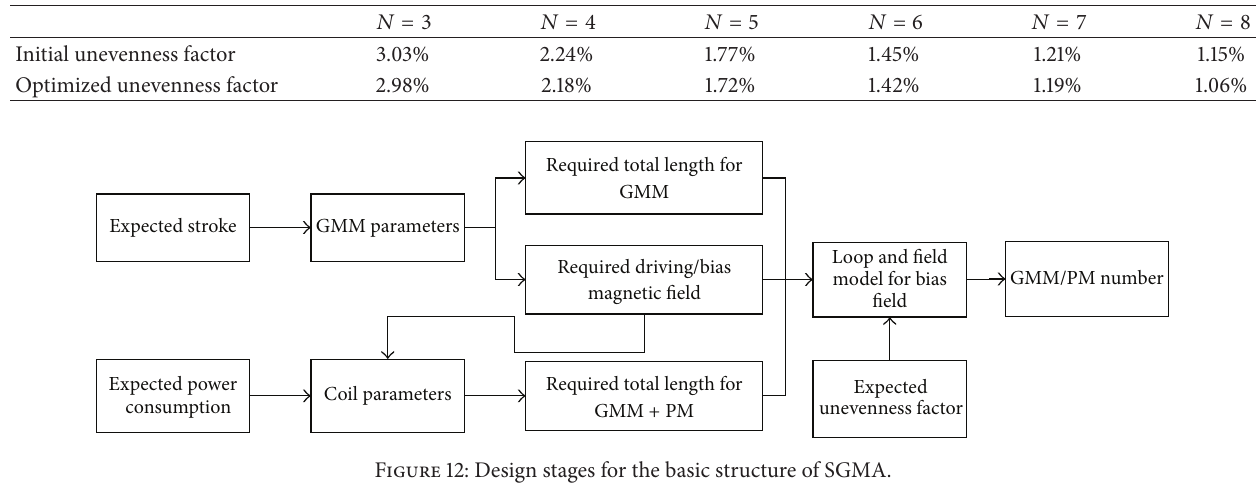
Table 2: Optimization result of each PM length in different cases.